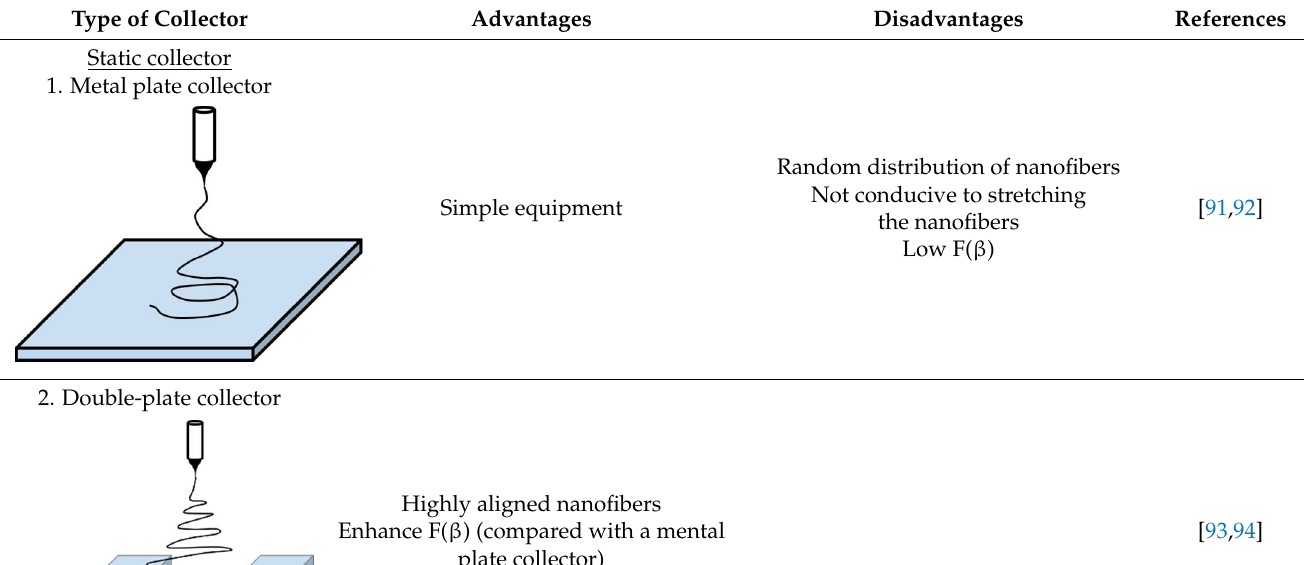
Table 1. Summary of different collectors in electrospinning.